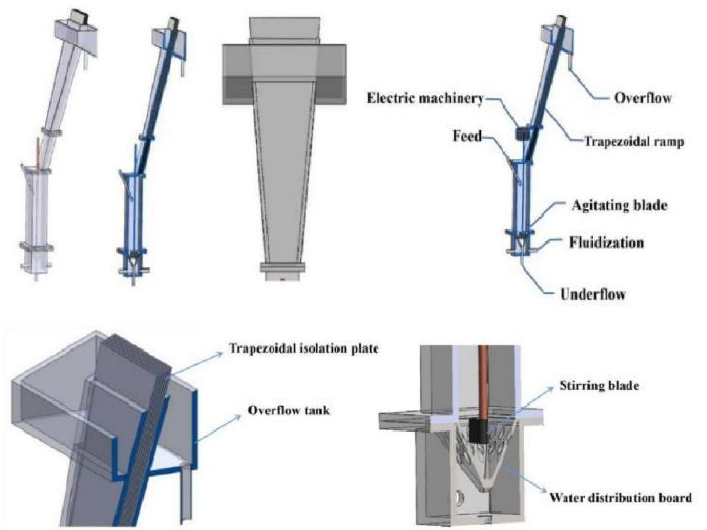
Figure 2. Diagram of the TARC (trapezoidal inclined channel agitated reflux classifier).